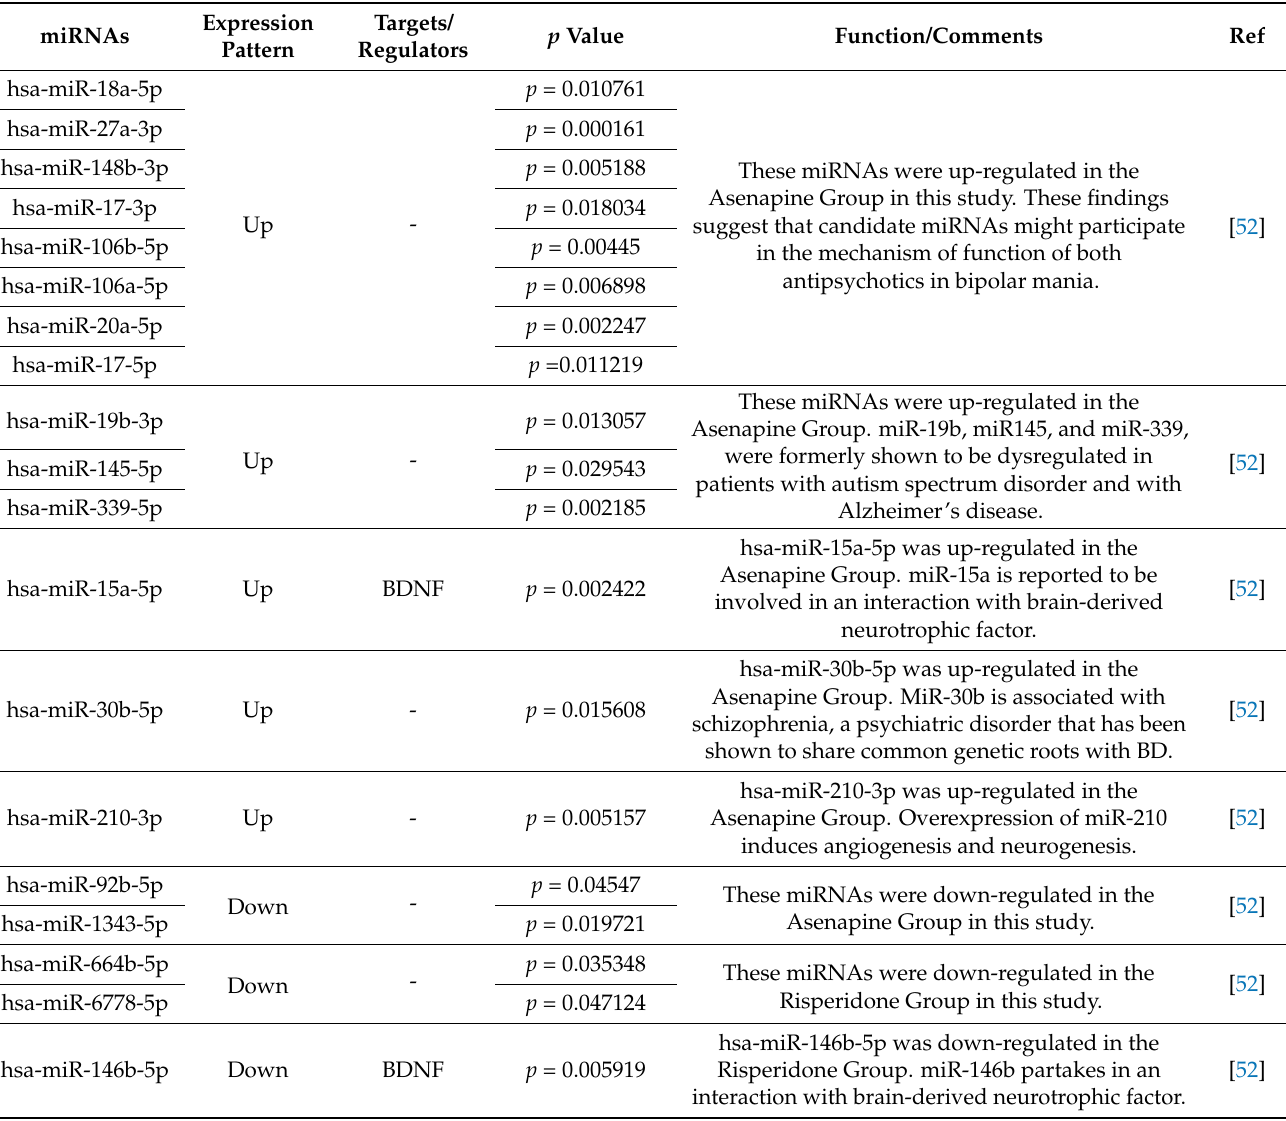
Table 7. Altered expression of miRNAs following treatment with antipsychotic